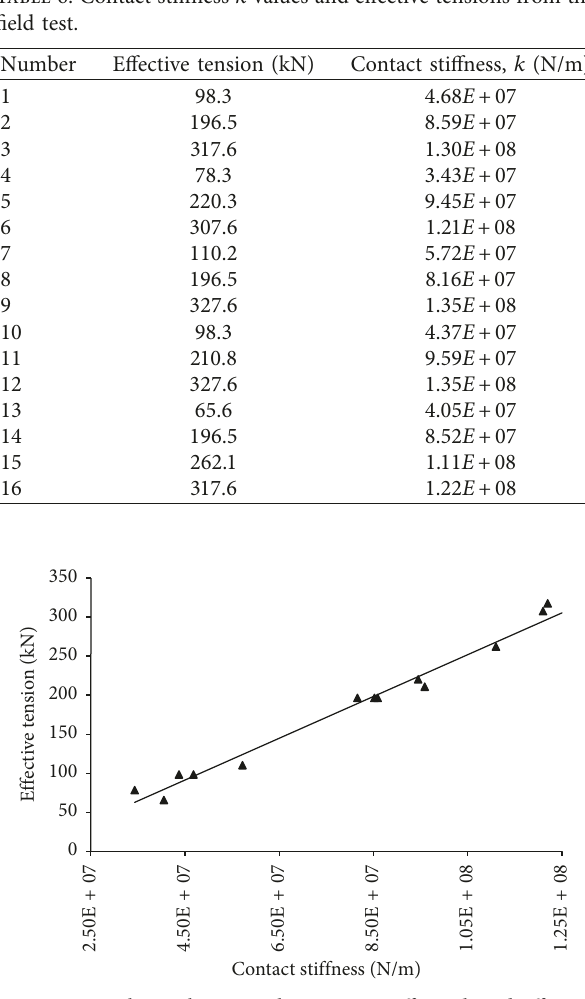
Figure 15: Relation between the contact stiffness k and effective tension from the field test.